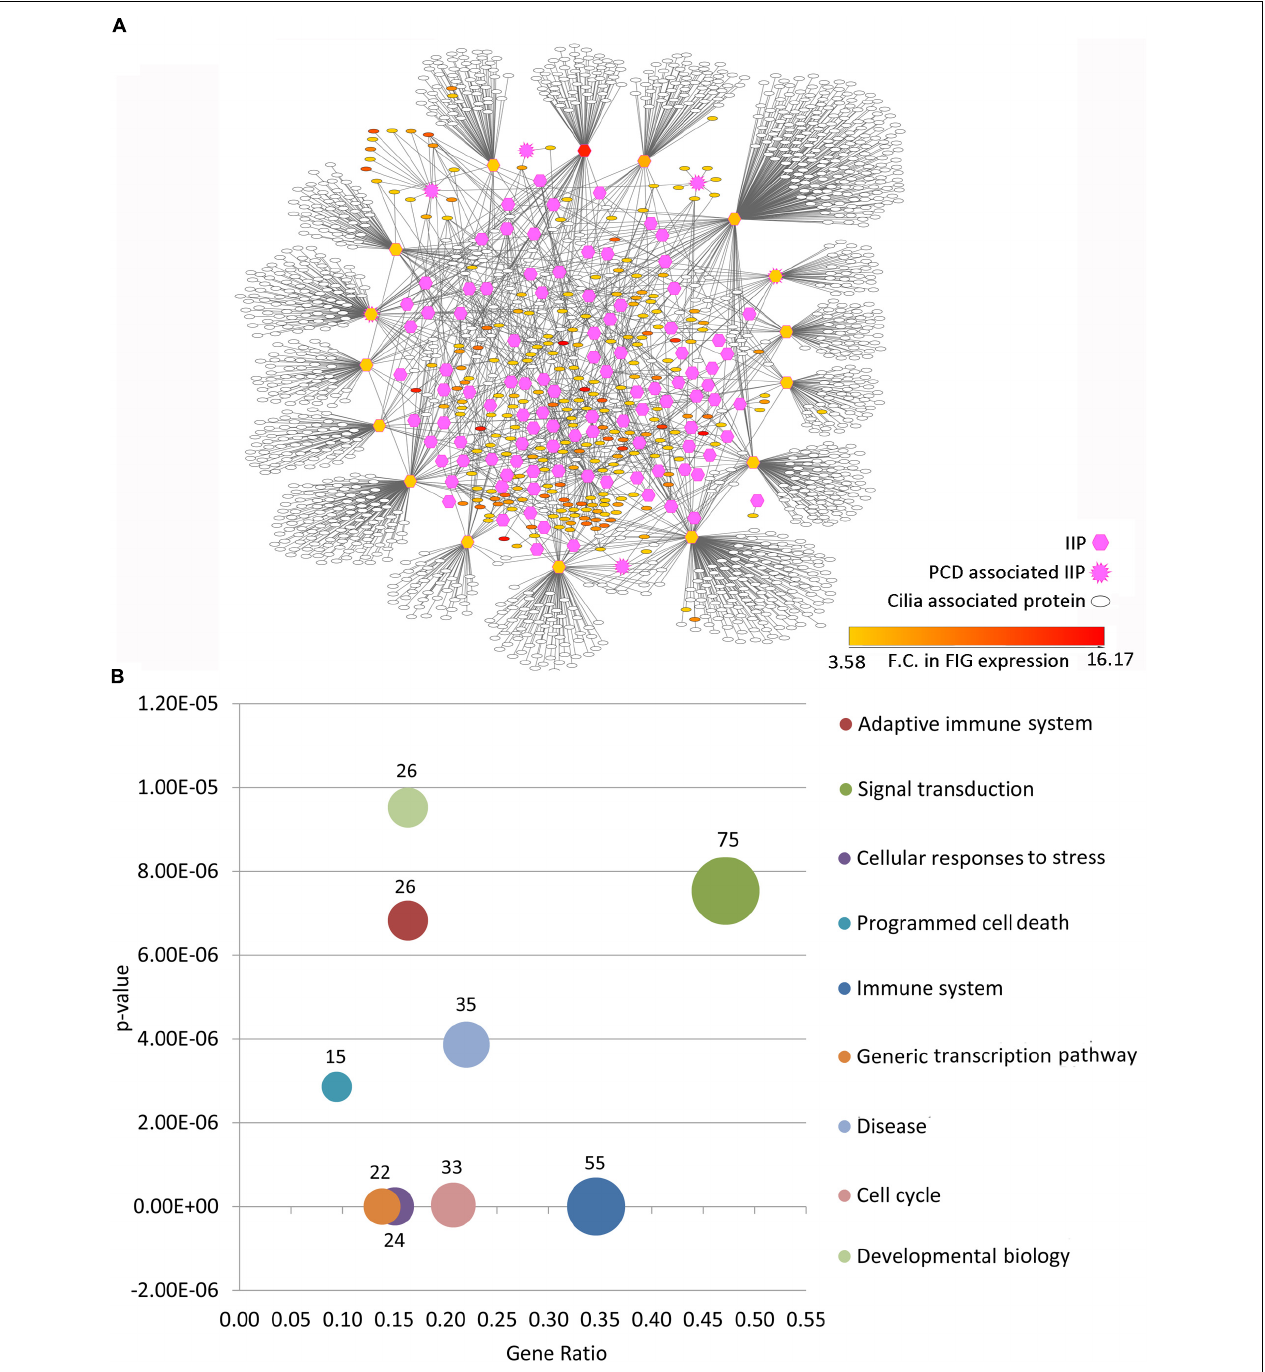
FIGURE 3 | Inter-relationship among IIP and FOXJ1 regulatory network proteins or FIGp. (A) The IIP (120) and their primary interactors form an inter-connected module with FIGp (246) within the motile cilia interactome as depicted here. (B) Cellular pathways that the inter-connected FOXJ1 regulatory network proteins and IIP (enriched pathways with p-value lower than 1e − 05 ) are likely to be involved in are shown. Abbreviations: F.C., Fold change; FIG, FoxJ1 induced genes; FIGp, FIG encoded protein; IIP, Important interacting proteins; PCD, Primary ciliary dyskinesia.